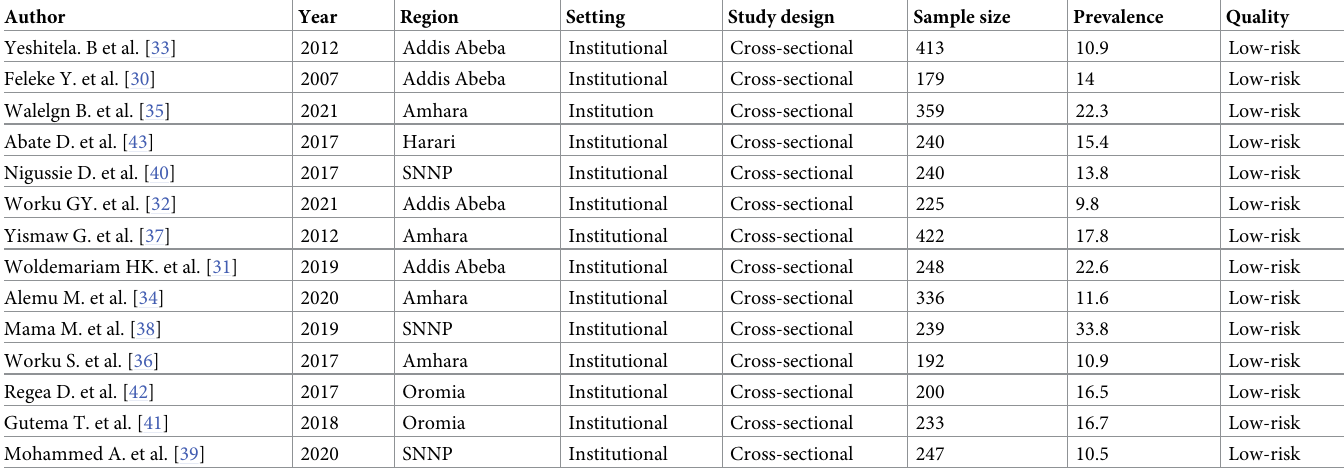
Table 1. Summary characteristics of studies included in the